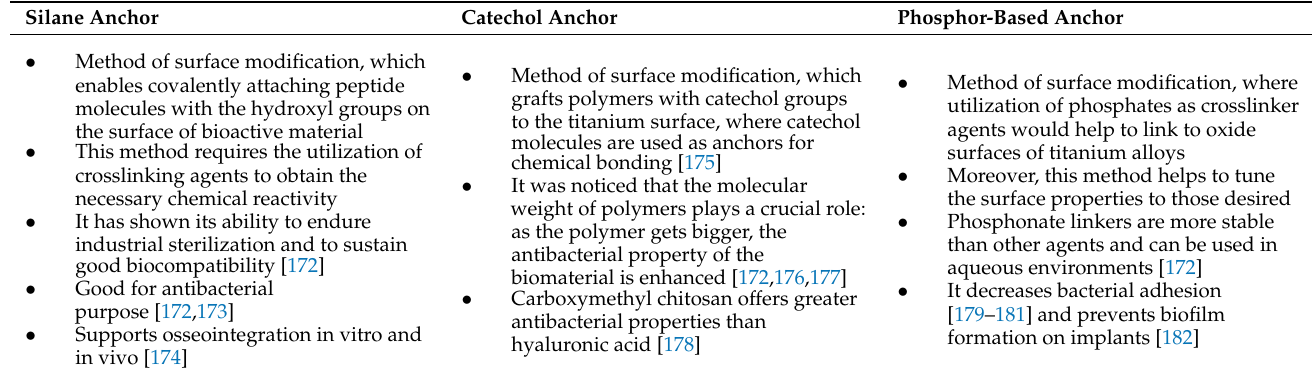
Table 12. List of anchor